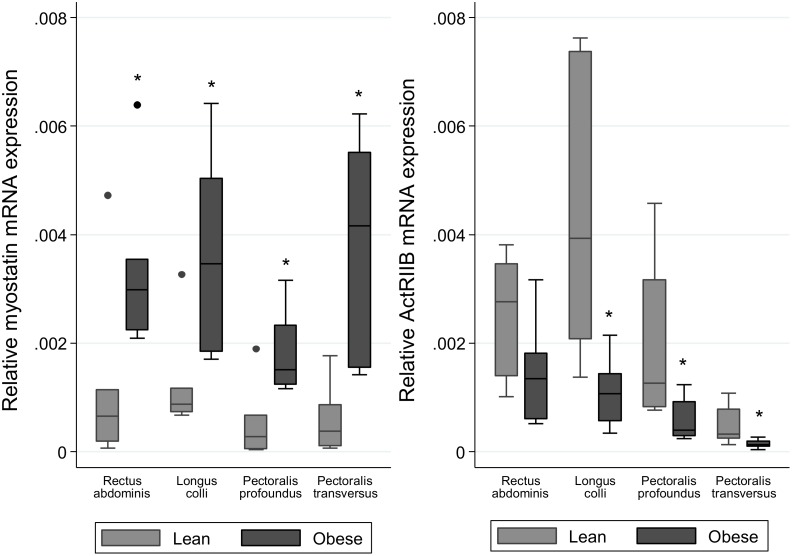
Gene expression of Myostatin and ActRIIB in skeletal muscles of lean and obese horses and ponies.Gene expression was analysed by real-time PCR and the geometric mean of the two most stable housekeeping genes as determined by GeNorm (GAPDH and beta-actin) was used for normalisation. Relative transcript abundance is shown for Myostatin (A) and ActRIIB (B). *denotes where values differ significantly (p<0.05) from lean group. n = 6/group.